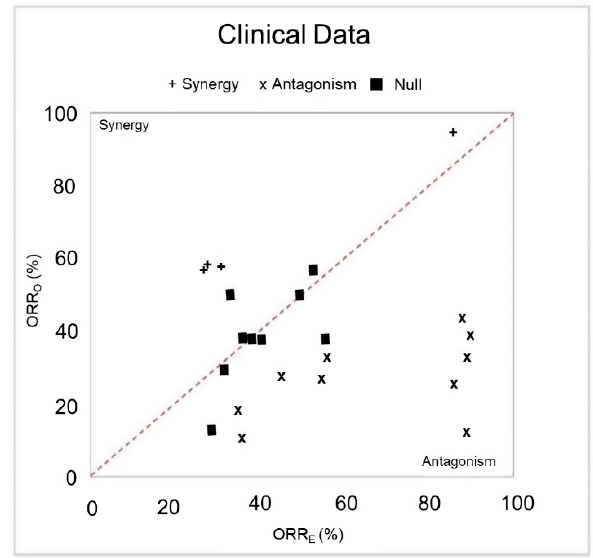
Figure 5. Clinical synergy and antagonism. The observed ORRs (ORR O ) as a function of the expected ORR (ORR E ) assuming no agent-agent interactions (null model). The diagonal line represents the perfect agreement with the null model. The left side and right side of the diagonal line correspond to the region of synergy and antagonism, respectively. (+) denotes combinations having evidence for synergy: ORR O > ORR E , p synergy < 0.05; ( × ) combinations having evidence for antagonism: ORR O < ORR E , p antagonism < 0.05; and black squares ( (cid:4) ) no significant difference from the null model.